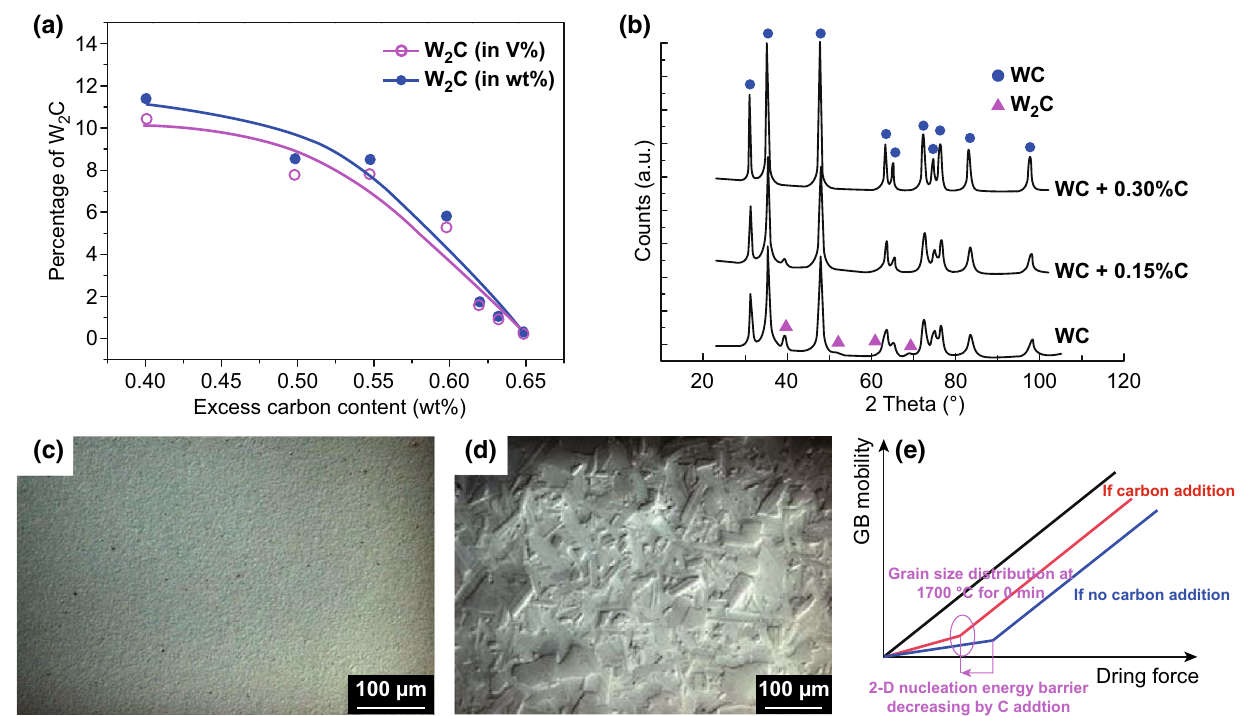
Fig. 2 a Percentage of impurity phase W 2 C phase in sintered sample obtained by SPS at 1800 °C for 6 min under the pressure of 70 MPa as a function of C addition in powders [32]. b XRD patterns of WC micro and WC ball milled with carbon addition, c WC + 0.15%C and d WC + 0.3%C SPS 2200 °C without holding time [40]. e Schematic of abnormal grain growth due to addition of C [41]. Figure panels reproduced from Ref. [32] with permission from Taylor & Francis copyright 2015, Ref. [40] with permission from Elsevier copyright 2008, Ref. [41]